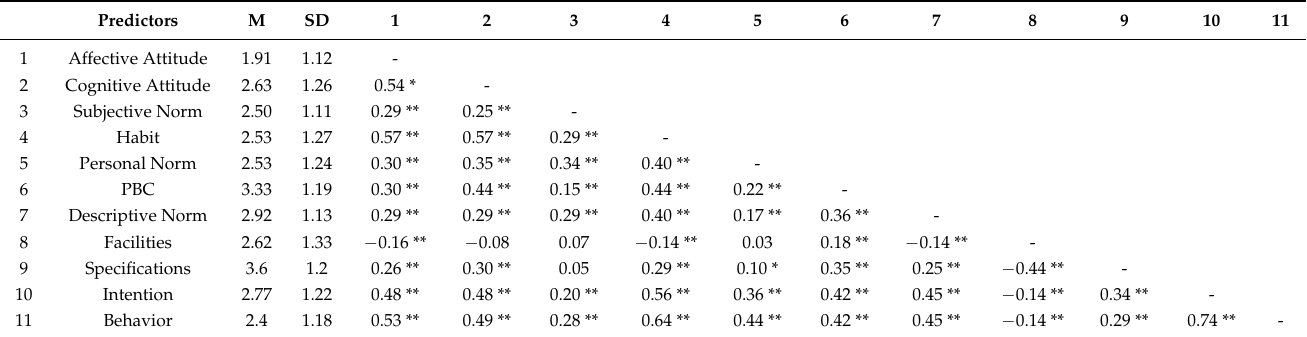
Table 3. Descriptive statistics and zero-order correlation between model structures.